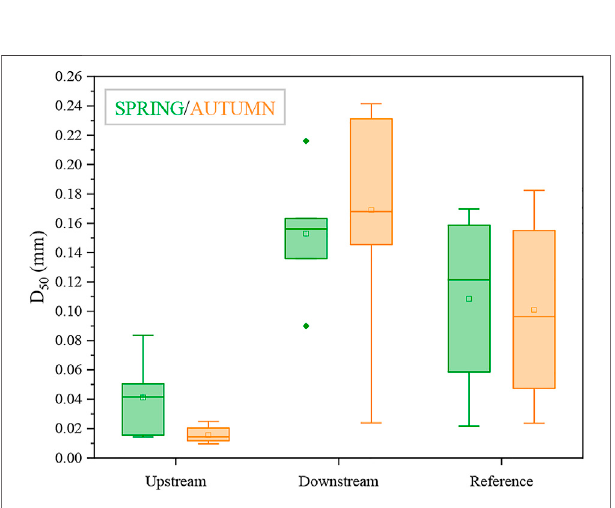
FIGURE 6 | The average diameter of the sediment grains (D 50 ) from the Bystrzyca River at the studied measuring points.